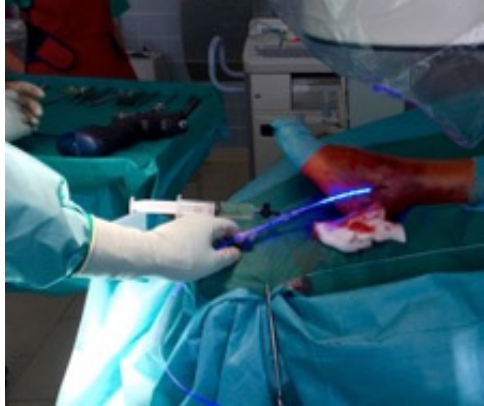
Figure 6. Here, the curing of the monomer by the visible light of 436 nm is shown. Group I patients were treated following the rehabilitation protocols (Table 1) of our trauma department, which allowed partial weight bearing restricted to 20 kg for 6 weeks, using crouches or a medical walking boot, and pain-adapted motion out of the walking boot without limitations, according to the recommendations of the German Society for Orthopedics and Trauma (DGOU) [44]. After the initial 6 weeks, these patients were allowed to increase the load of weight bearing with the goal to achieve full weight bearing within 10 weeks after surgery.